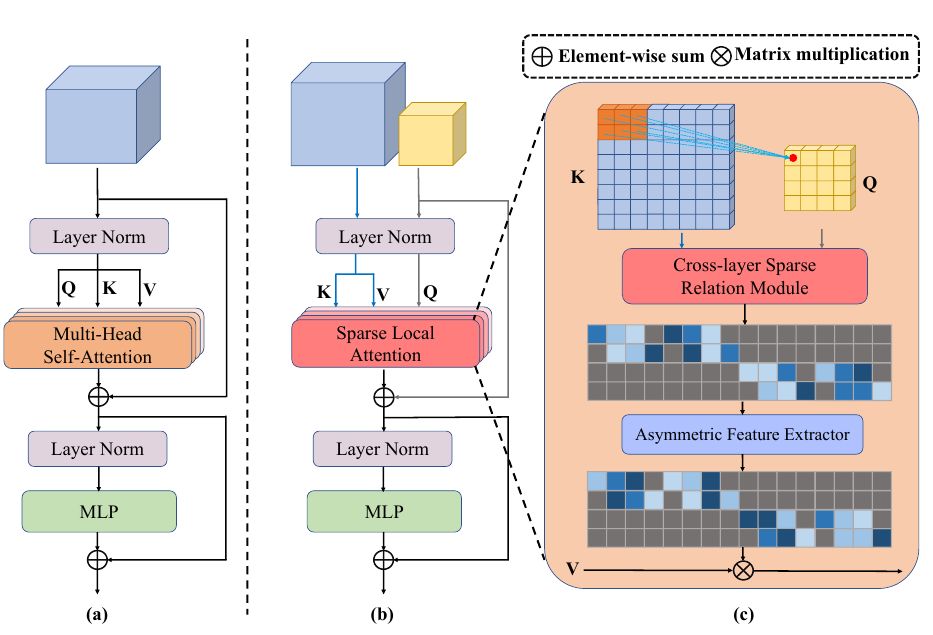
Figure 7. Overview of the CA-Trans module. ( a ) is the vanilla ViT module that generates Q , K , and V from a single feature map and uses multi-head self-attention (MHSA) to obtain attentions. ( b ) shows the architecture of our CA-Trans, where K and V are generated from f 1 , while Q is generated from f (cid:48) Otherwise, we replace the MHSA with the sparse local attention (SLA) to extract attentions between two different layers. ( c ) is the SLA. By introducing the cross-layer sparse relation module (CSRM) and asymmetric feature extractor (AFE), our CA-Trans can efficiently extract asymmetric information between two paths and enrich the features of small